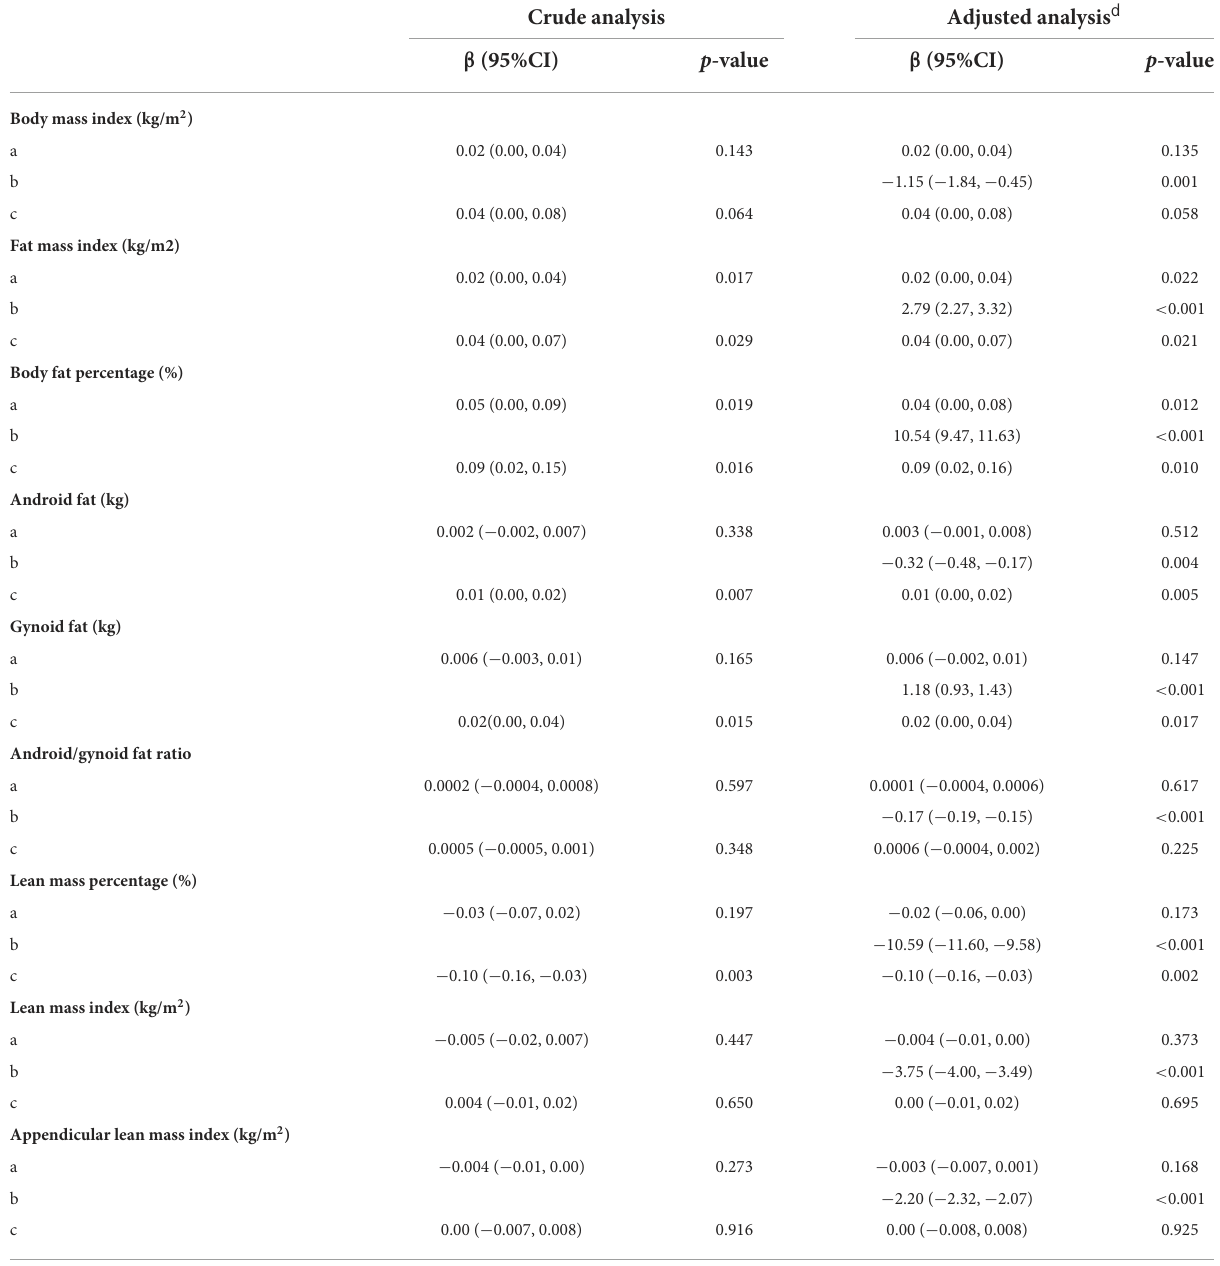
TABLE 4 Crude and adjusted linear regression analysis between ultra-processed foods consumption (% grams) at 23–25 years (2002/2004) and body composition measurements at 37–39 years (2016/2017) in participants of the 1978/1979 Ribeirão Preto birth cohort study (São Paulo, Brazil). Body composition